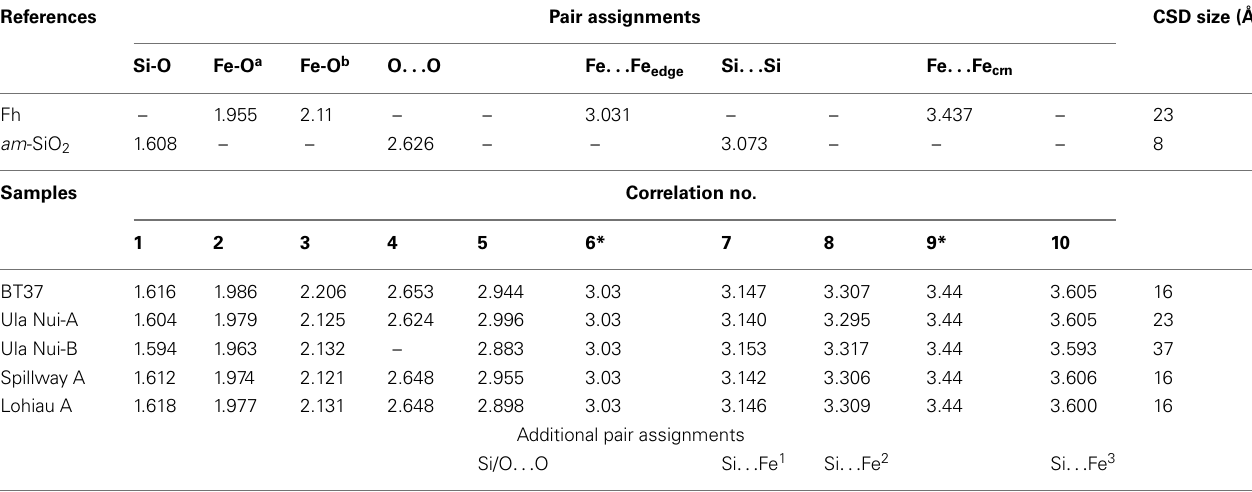
Table 3 |Atom pair separations and coherent scattering domain sizes extracted from PDF analysis of references and selected mat samples.